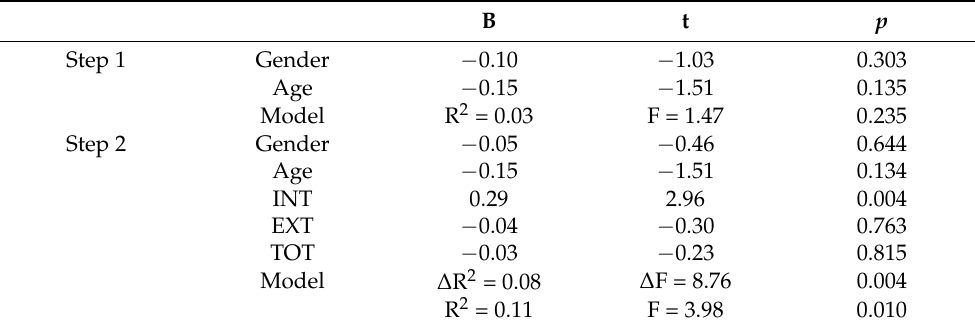
Table 3. Results of a hierarchical regression analysis with BMI as the dependent variable and the Child Behavior Checklist (CBCL) broad band scales as predictors (N =